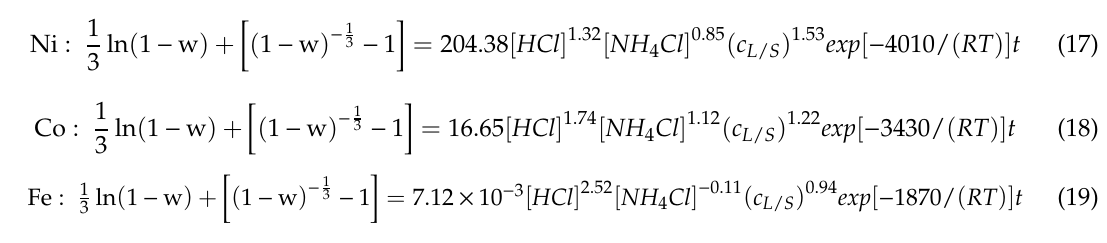
Figure 13. The ln k − ln c L/S of Ni, Co, and Fe.